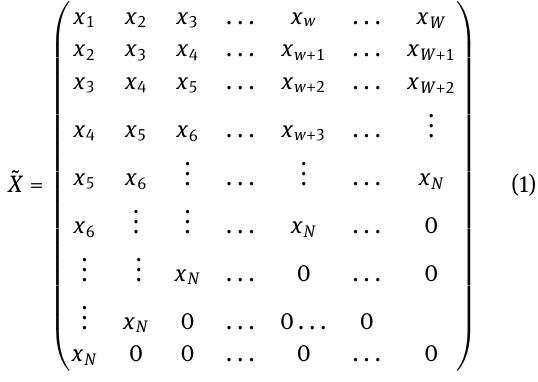
Position of the throttling valve was described by the dimensionless throttle opening area parameter referred to as TOA. TOA = 100% corresponds to fully opened valve, while TOA = 0% corresponds to fully closed valve. Each measurementcontained2 21 samplesgatheredwiththefre- quency of 100 kHz.